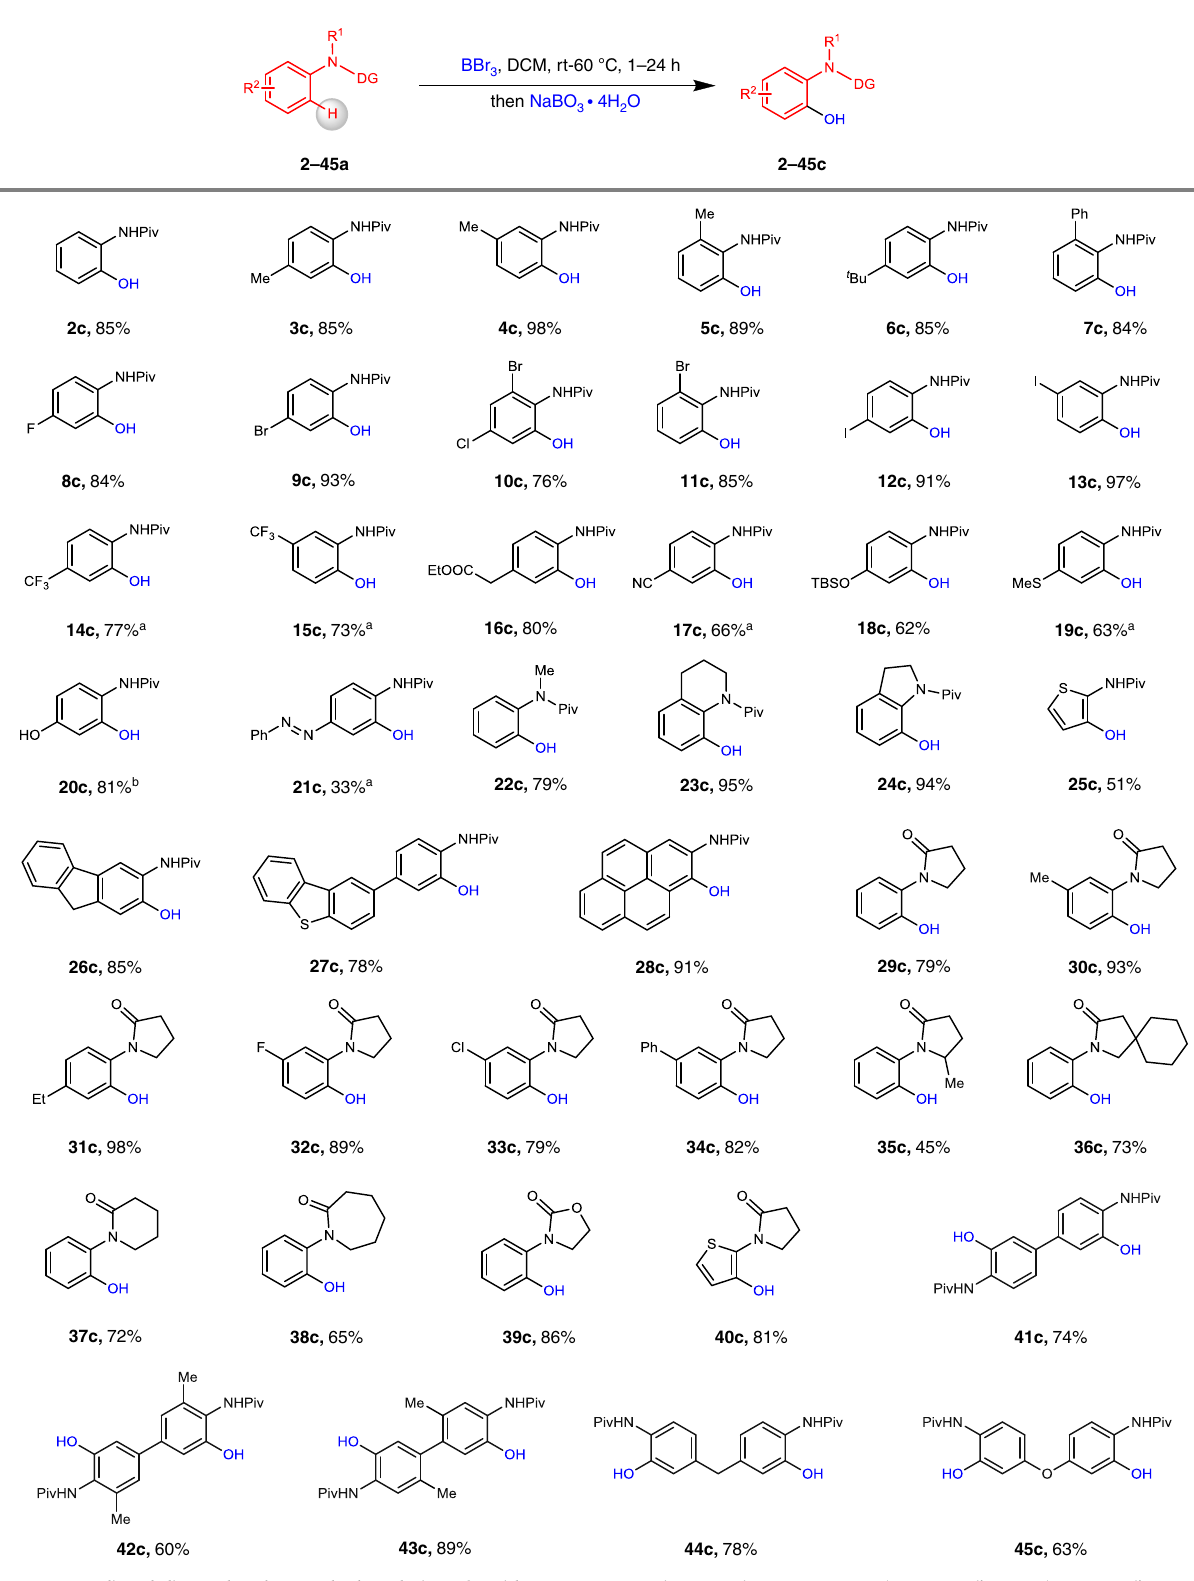
Fig. 2 Boron-mediated directed ortho C – H hydroxylation of amides. Reaction conditions: substrates 1a – 28a (0.20 mmol), BBr 3 (0.22 mmol) in 0.5 mL DCM at room temperature, 1 h, under Ar; NaBO 3 ·4H 2 O (0.60 mmol) in 0.5 mL THF and 0.5 mL H 2 O, at room temperature, 1 h. 29a – 40a (0.20 mmol), BBr 3 (0.60 mmol) in 0.5 mL DCM at 60 °C, 24 h; NaBO 3 ·4H 2 O (0.60 mmol) in 0.5 mL THF and 0.5 mL K 2 CO 3 (aq), at room temperature, 1 h. 41a – 45a (0.20 mmol), BBr 3 (0.40 mmol) in 0.5 mL DCM at room temperature, 1 h, under Ar; NaBO 3 ·4H 2 O (1.50 mmol) in 0.5 mL THF and 0.5 mL H 2 O, at room temperature, 1 h. a Using BBr 3 (2.0 mmol) in 0.1 mL of DCM. b N -(4-methoxyphenyl)pivalamide (0.20 mmol), BBr 3 (0.5